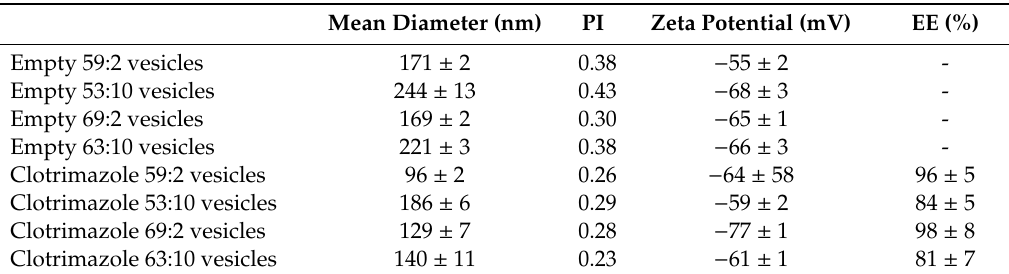
Table 2. Mean diameter, polydispersity index (PI), zeta potential, and entrapment efficiency (EE) of empty and clotrimazole-loaded three-dimensionally-structured hybrid vesicles. Mean value ± standard deviation was obtained from six independent samples.